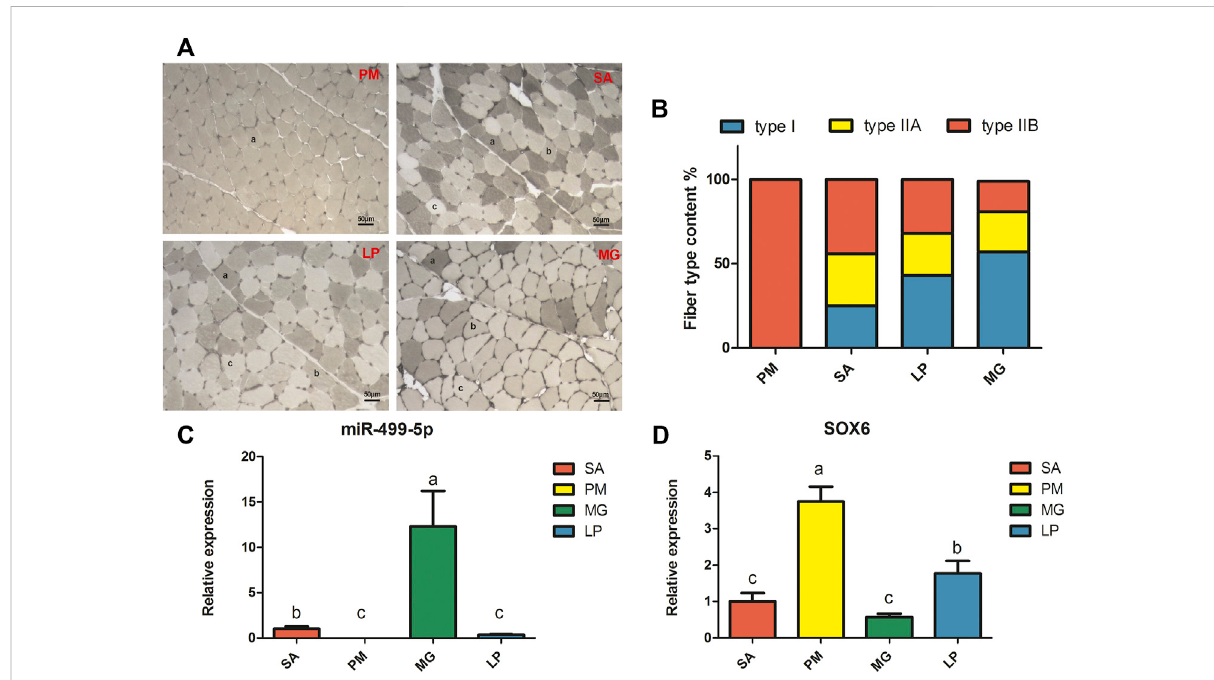
FIGURE 1 Myo fi ber type phenotype and gene expression levels in four different skeletal muscles. (A) Myosin ATPase staining of four different skeletal muscles.PM: pectoralismajor ,SA: sartorius ,LP: lateralpectineus ,MG: medialgastrocnemius . (A) typeIIB fi bers, (B) typeIIA fi bers, (C) typeI fi bers.